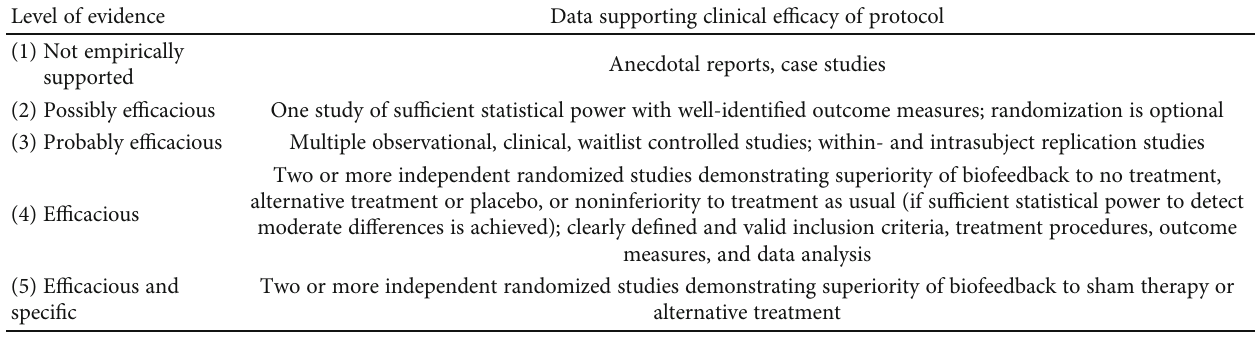
Table 1: Description of requirements of each level of evidence. Summarized from [11]. Level of evidence Data supporting clinical e ffi cacy of